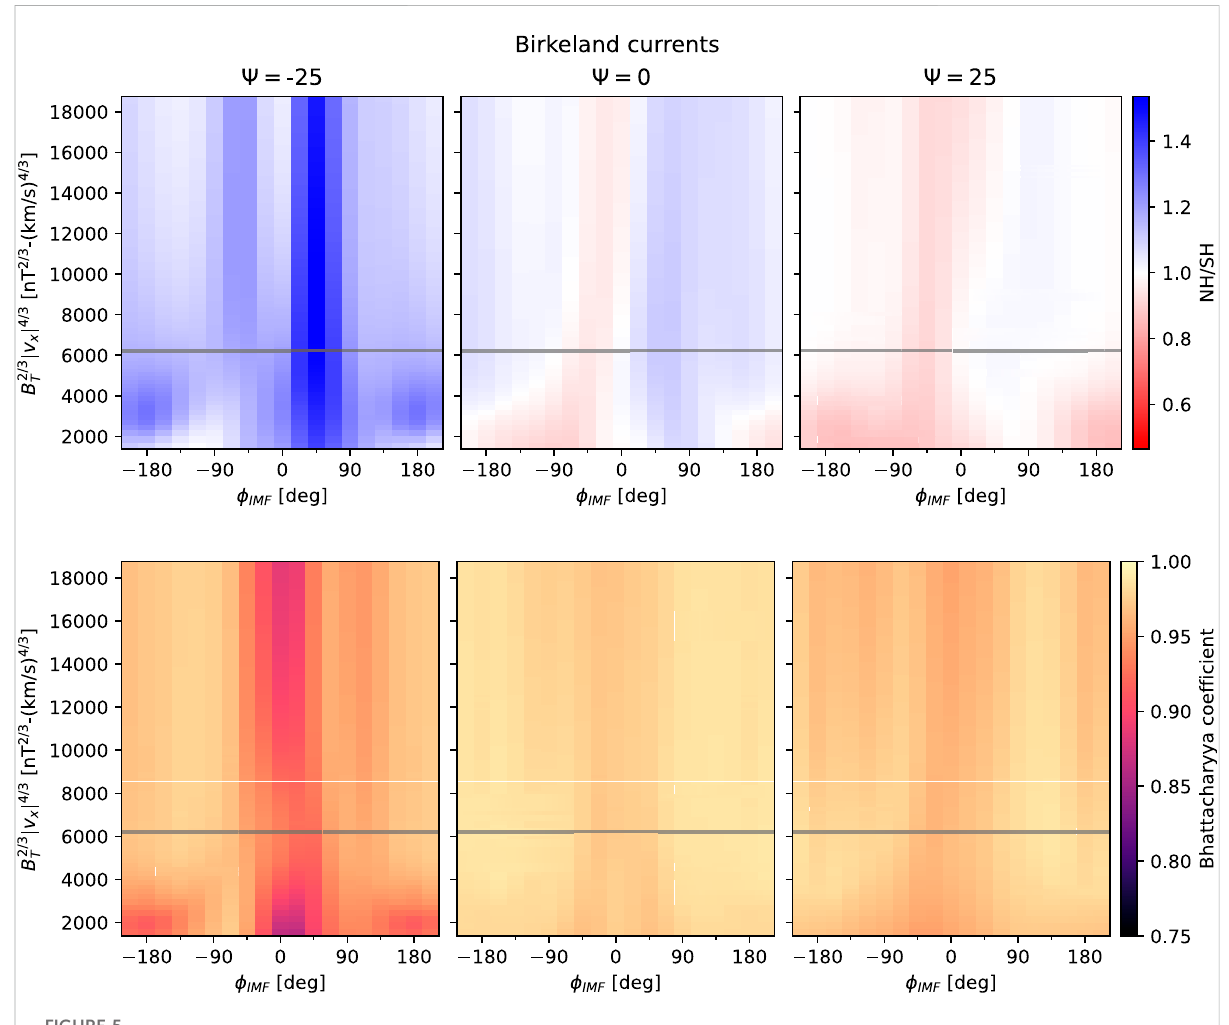
FIGURE 5 NorthernandsoutherntotalBirkelandcurrentratio(toprow)andBhattacharyyacoef fi cient(bottomrow)asafunctionofIMFclockangle θ c and x and y axis, respectively) for dipole tilt angles − 25 ° , 0 ° , and 25 ° (panels from left to right). The sign of B y (and therefore also θ c ) as well as ψ | v x | 4/3 B 2/3 T ( arereversedfortheSouthernHemisphere.Thehorizontalblacklinecorrespondstothevalues B T =4 nTand v x = − 350 km/susedinFigures2 – 4.For fi xed v x = 400 km/s, the minimum and maximum values on the y axis correspond to B T = 0.375 nT and B T = 16